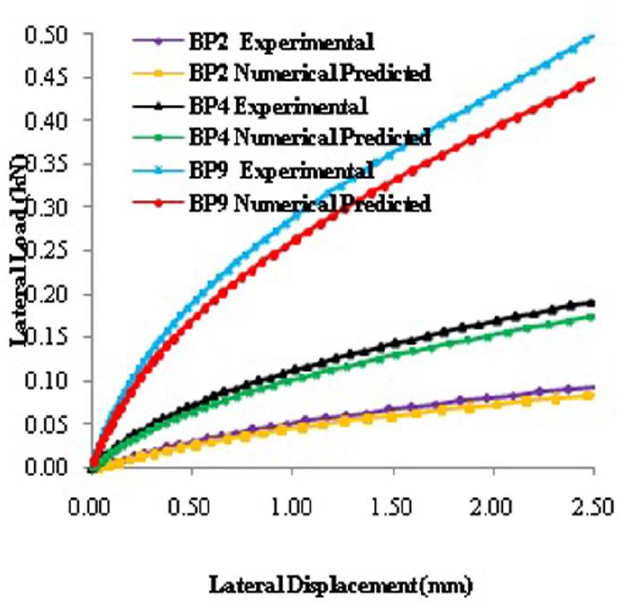
Fig. 9. Comparison between the experimental and predicted and lateral load results at 3D pile spacing of bamboo pipe piles in of loose layer in-between dense layers for slenderness ratio as 25.